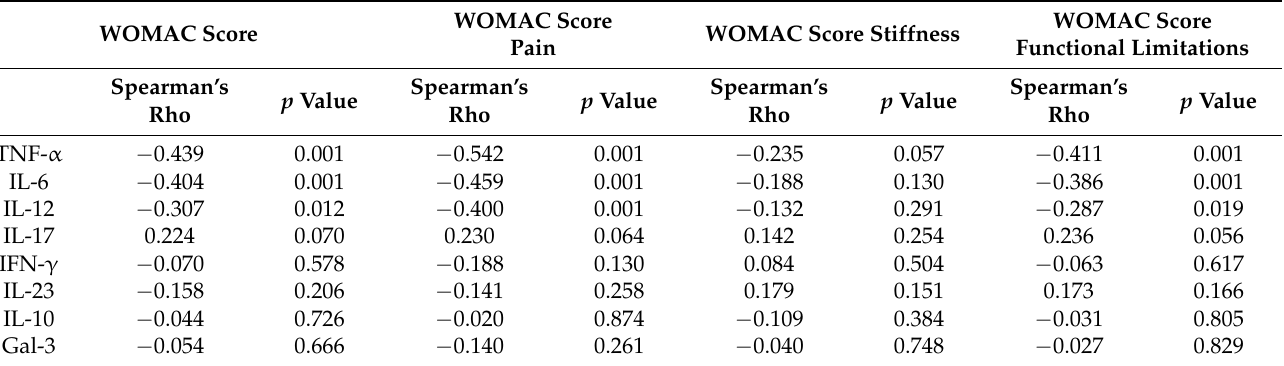
Table 6. Correlations between WOMAC scores and